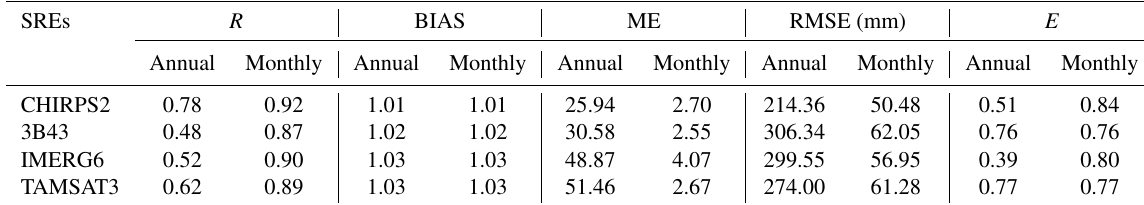
Table 3. Statistical evaluation indices of all SREs.